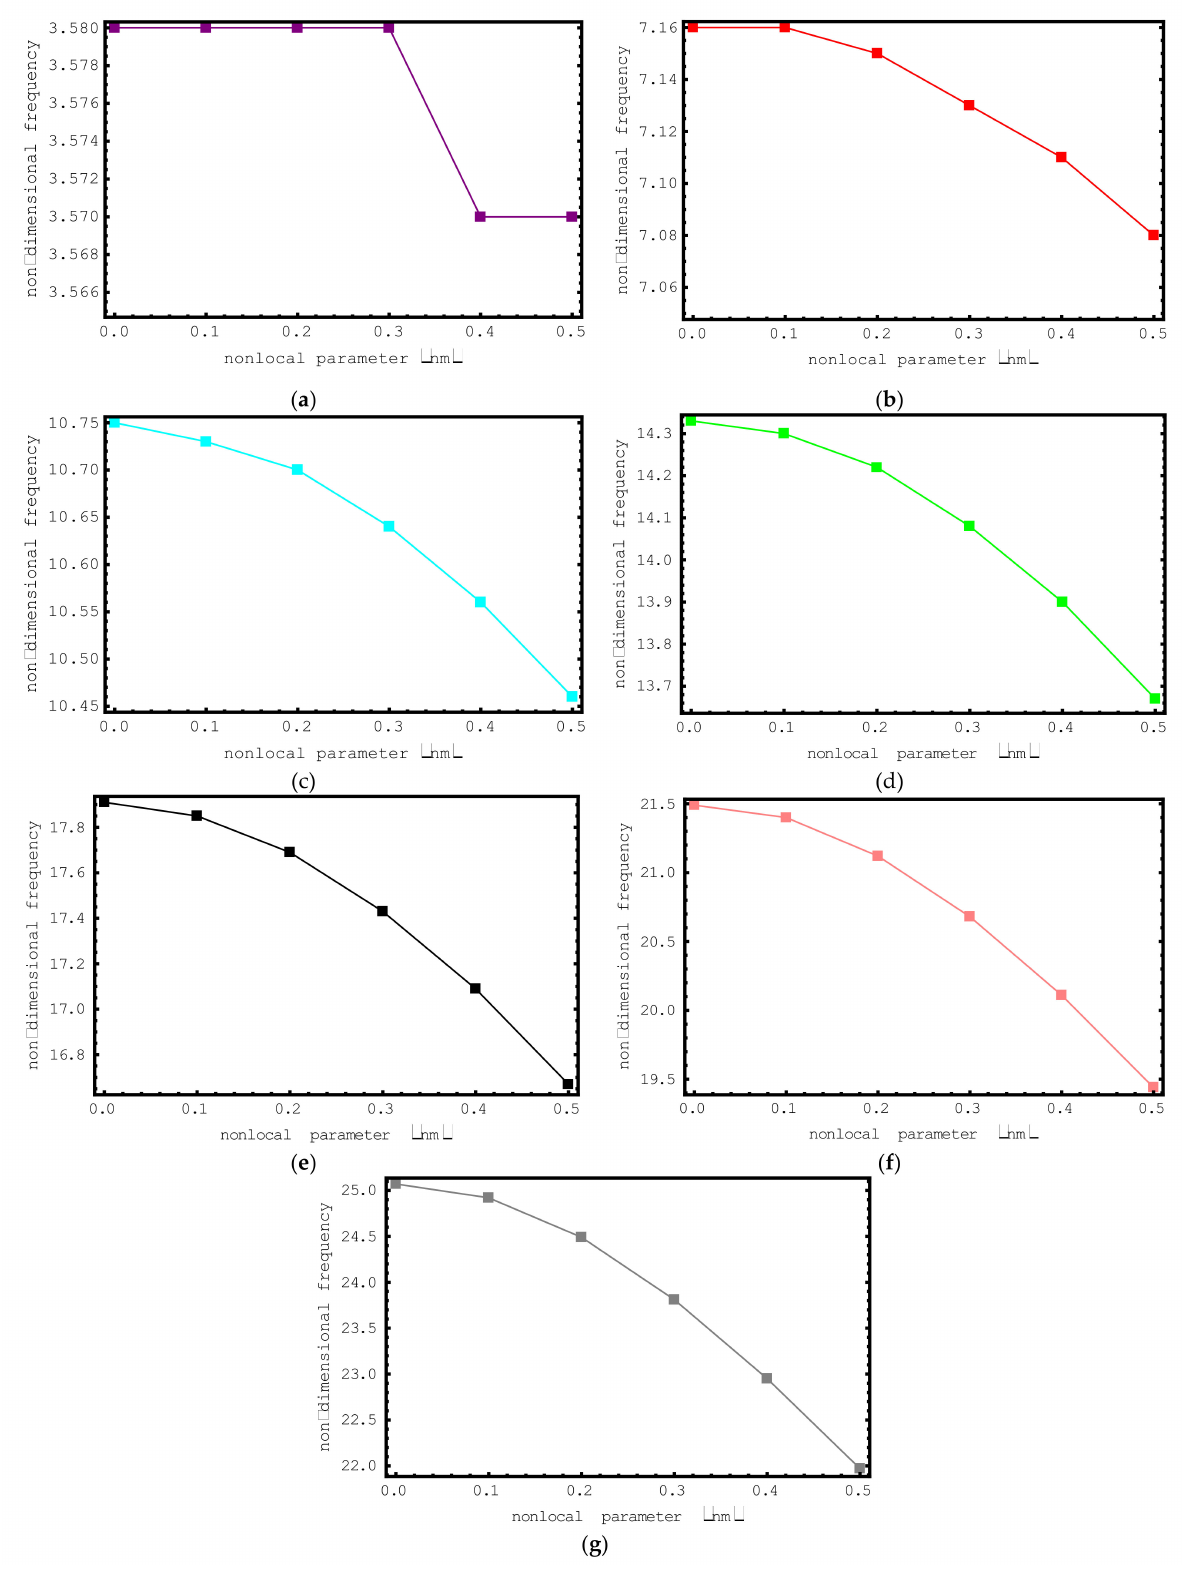
Figure 3. The variations of non-dimensional frequencies of short-fiber-reinforced composite nano- rods versus nonlocal parameter: ( a ) 1st mode ( b ) 2nd mode ( c ) 3rd mode ( d ) 4th mode ( e ) 5th mode ( f ) 6th mode ( g ) 7th